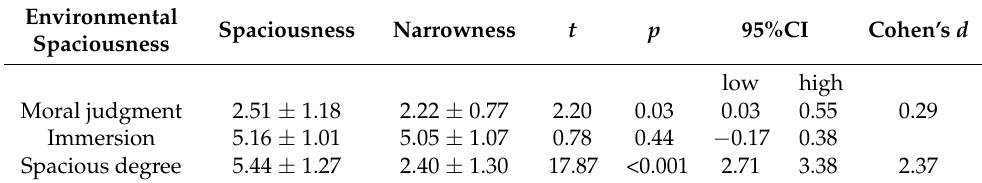
Table 1. The Mean rating score of moral judgment in different